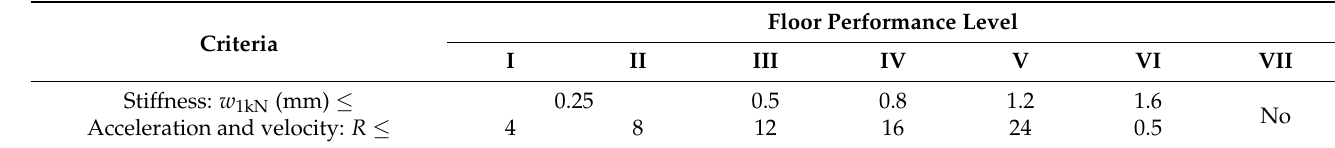
Table 1. Limit values for vibration criteria according to the floor performance level.